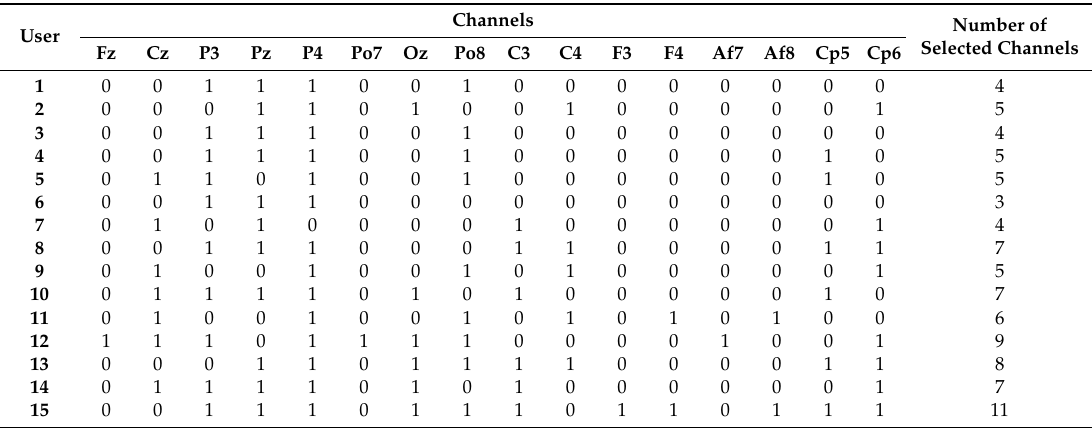
Table 3. The optimized channels for all the 15